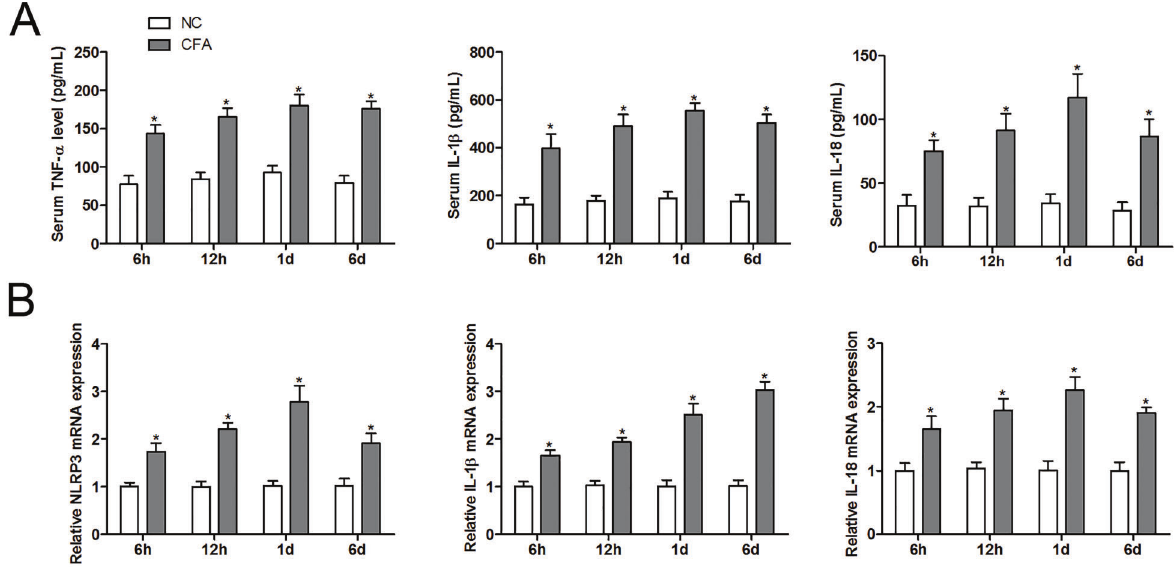
Figure 3. Complete Freund ’ s adjuvant (CFA) activated NLRP3 in fl ammasome signaling in mice with trigeminal neuropathic pain. Serum levels of tumor necrosis factor-alpha (TNF- a ), interleukin-1beta (IL-1 b ), and interleukin-18 (IL-18) were assayed using a double antibody sandwich ELISA at each time-point ( A ). The mRNA expression of NLRP3, IL-1 b , and IL-18 were measured by RT-qPCR at each time-point ( B ) (n=6). Data are reported as means ± SD. *P o 0.05 vs control group (NC) (ANOVA followed by a post hoc Tukey ’ s